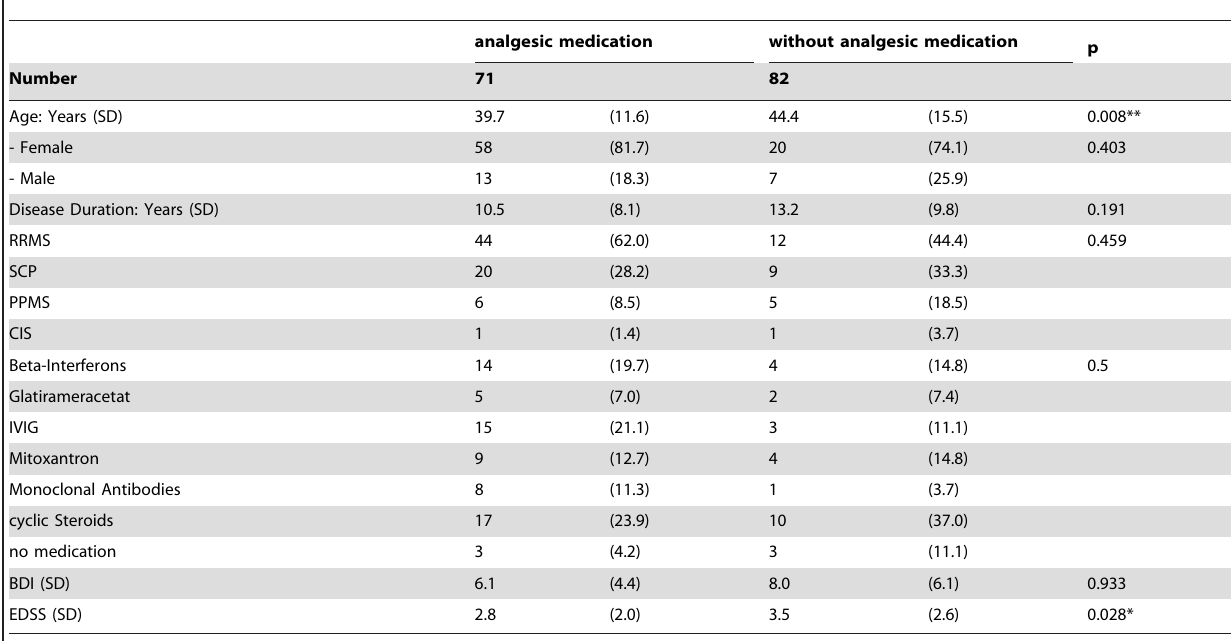
Table 4. Comparison of sociodemographic and neurological parameters in MS-patients with and without analgesic medication.